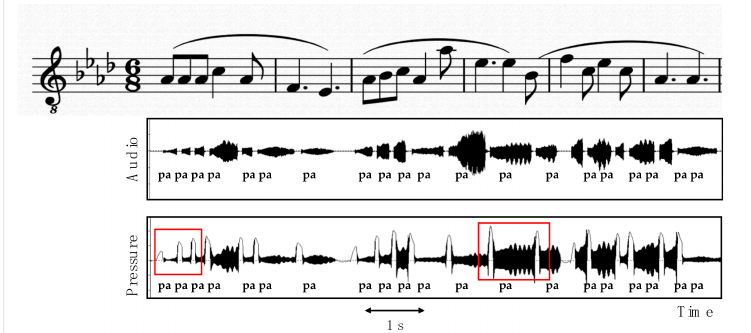
Figure 5. Recording of the first 6 bars of the aria, “O mio babbino caro”, from the opera Gianni Schicchi by G. Puccini, sung by a female soprano on the syllable /pa/. Intraoral pressures were recorded with the PG-100E unit and audio with an omnidirectional microphone. Both signals are displayed with the software Sopran. Red boxes highlight relevant pressure events related to musical phrasing (see